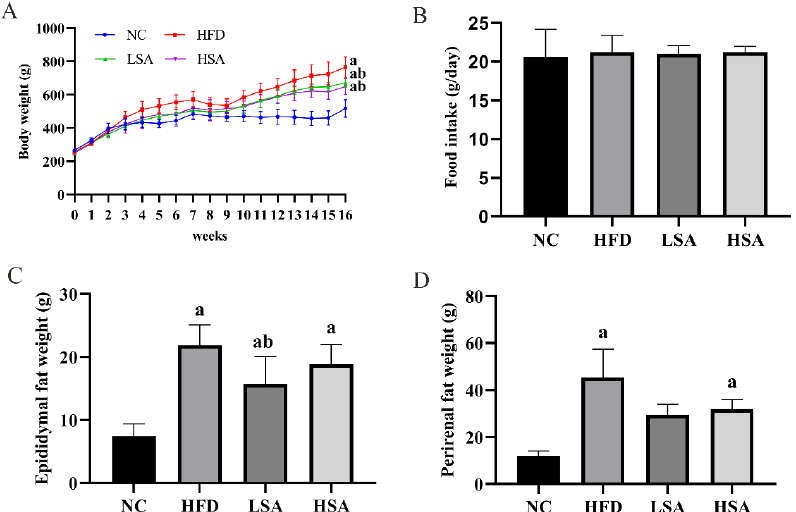
Figure 1. SA supplementation reduced body weight. ( A ) Weight change during the 16-week experiment; ( B ) food intake; ( C ) epididymal fat weight; ( D ) perirenal fat weight. n = 8 each group. a p < 0.05, compared to the NC group; b p < 0.05, compared to the HFD group.